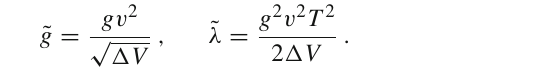
| φ (cid:14) | = 0 . 01, respectively, and the color coding indicates the value